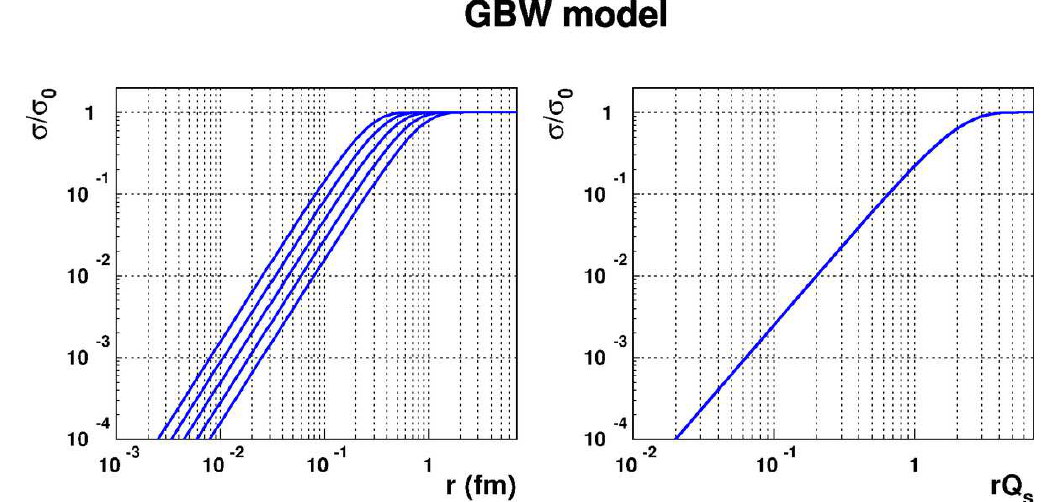
Figure 1 . Dipole cross section (2.6) with the parameters from Fit 2 in table 1 as a function r (left plot) and rQ s (right plot) for x = 10 − 6 , . . . , 10 − 2 (curves from left to right, respectively). All the curves in the left plot merge into one line in the right plot due to geometric scaling (2.8).